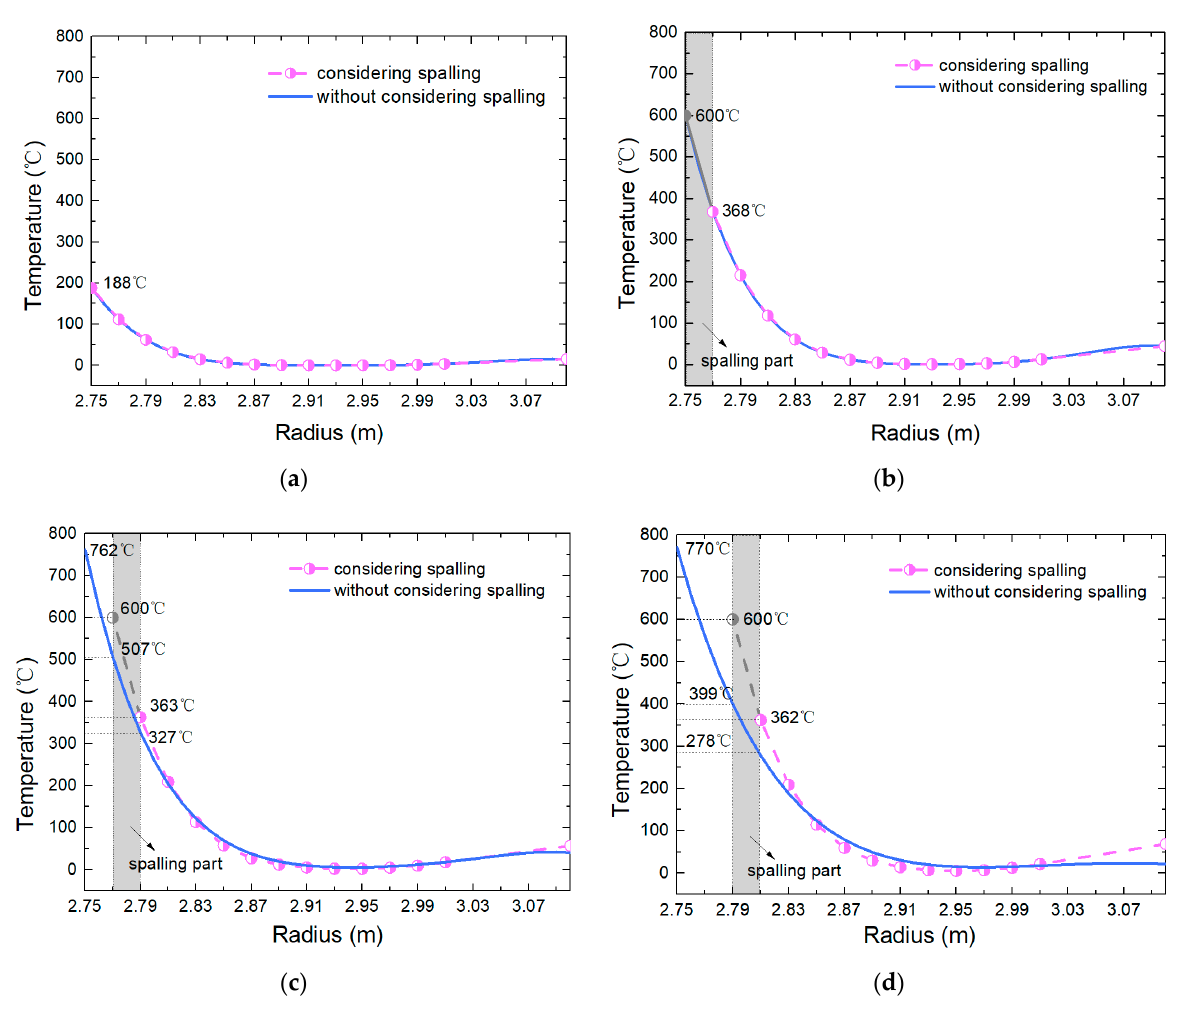
Figure 15. Temperature distributions of tunnel lining under fire (the maximum temperature of 800 °C) ( a ) 1 min after fire; ( b ) 1st spalling (15.88 min); ( c ) 2nd spalling (33.88 min); ( d ) 3rd